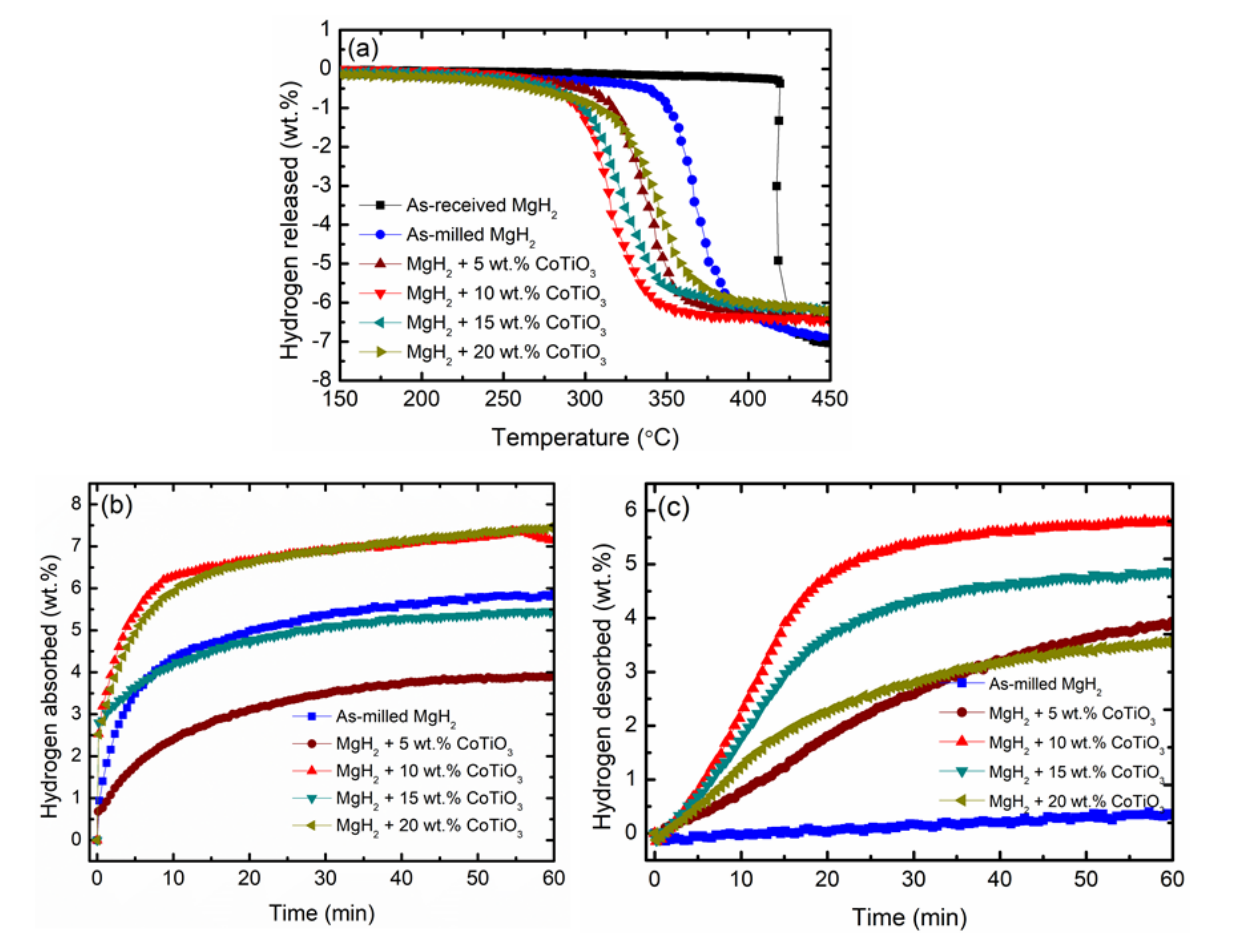
Figure 2. ( a ) TPD, ( b ) hydrogen absorption at 200 ◦ C under 33.0 atm H 2 pressure, and ( c ) hydrogen desorption curve at 300 ◦ C under 1.0 atm H 2 pressure of the MgH 2 –CoTiO 3 system. The reversibility of the MgH 2 –CoTiO 3 system was further studied via an absorption kinetic experiment conducted at a low temperature (200 ◦ C). The doped sample was studied with a different weight percentage of CoTiO 3 , as demonstrated in Figure 2b. Among the four different wt.%, MgH 2 + 10 wt.% CoTiO 3 produces the fastest absorption rate and represents improved absorption kinetics performance than does undoped MgH 2 . As